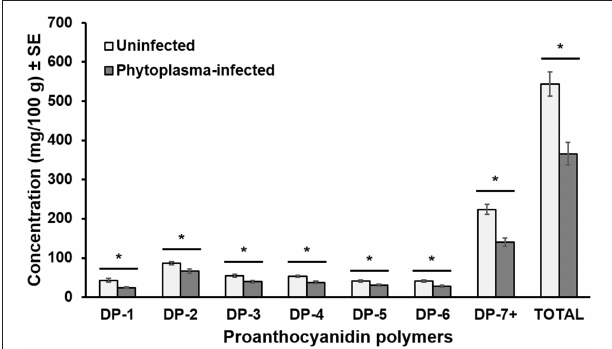
FIGURE 5 | Mean ( ± SE) amounts of proanthocyanidin polymers in uninfected and phytoplasma-infected cranberry leaves. DP, degree of polymerization. An asterisk indicates statistically significant differences (* p ≤ 0.05). N =